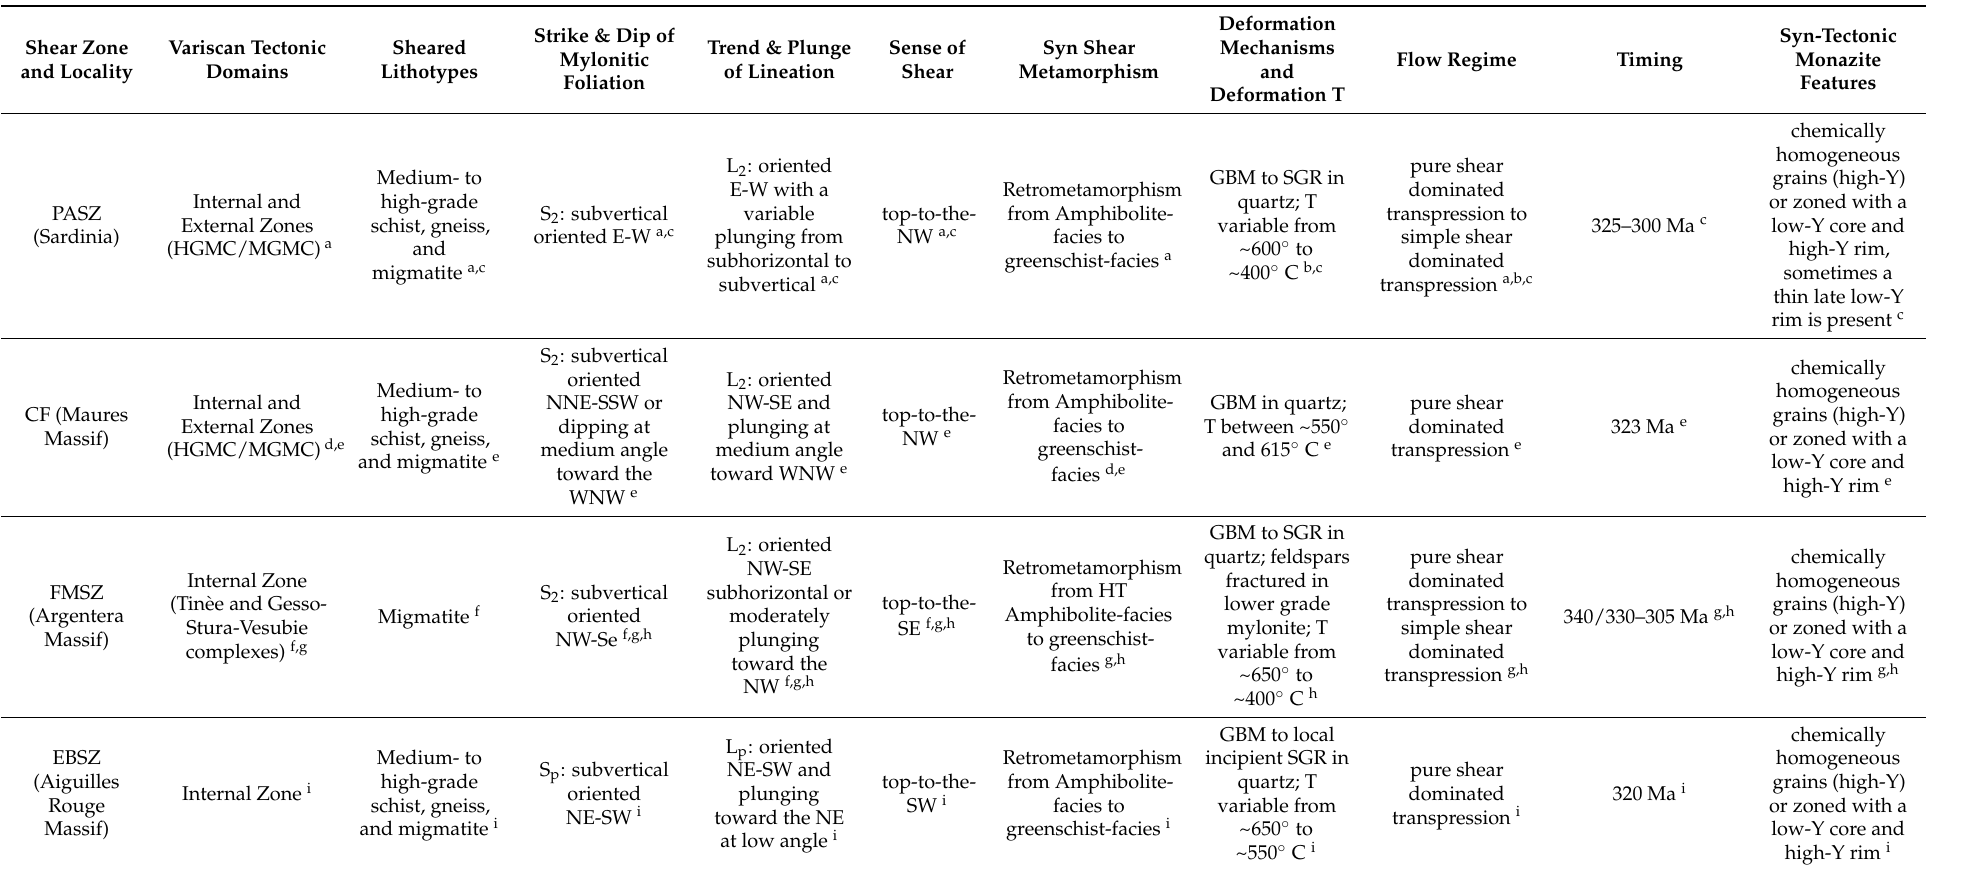
Table 1. Summary of structural and geochronology data sets of the branches of the EVSZ in the Mediterranean area